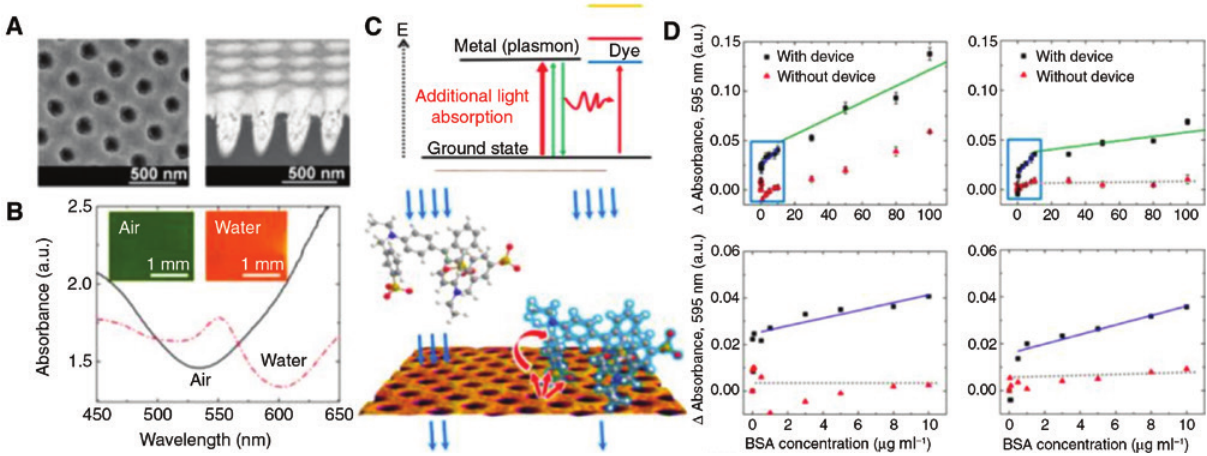
Figure 5: Absorbance amplification on nanocup array structure (nanoLCA). (A) SEM image of the nanocup array structure in top-down view and in a cross-section view. (B) Absorbance spectra of the nanocup array structure in air and in water. (C) Schematic representation of energy diagram to show energy transfer mechanism between plasmon and dye molecule. (D) Relative absorbance changes with increasing BSA concentration with and without the nanocup array structure (A–D reprinted with permission from [64]; copyright (2015) American Chemical